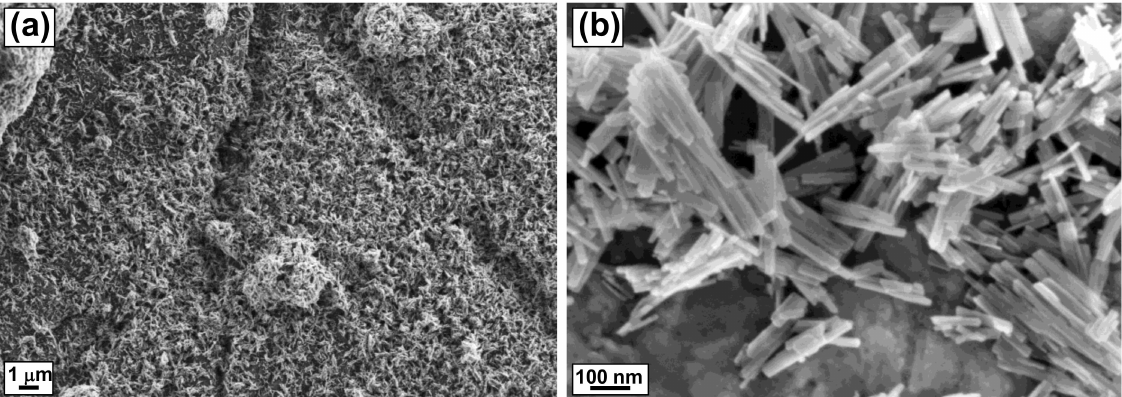
Figure 2. FESEM images of CdS NRs ( a , b